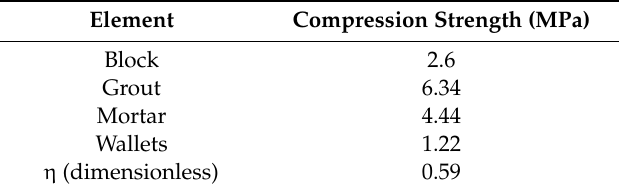
Table 7. Strength parameters of CEB partially reinforced masonry components [39].